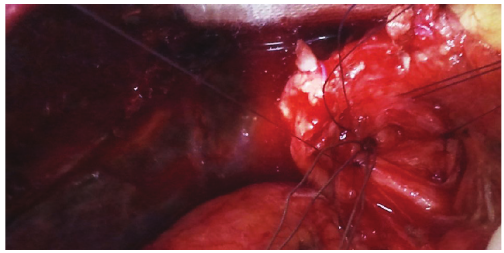
Figure 1: Intraoperative picture showing Dormia basket entrapped in the cystic duct.